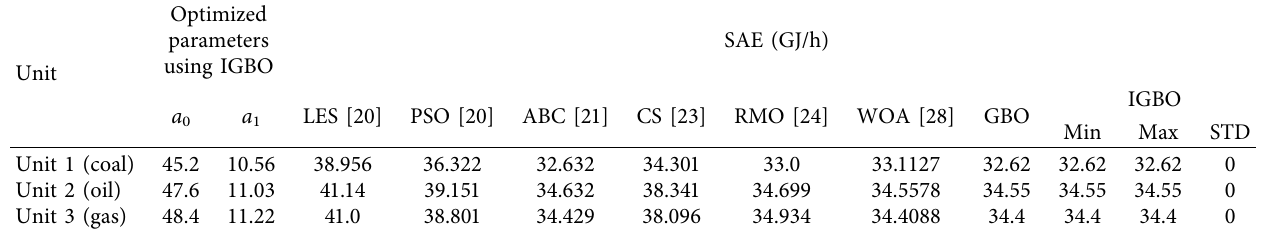
Table 6: Optimized parameters and SAE of model